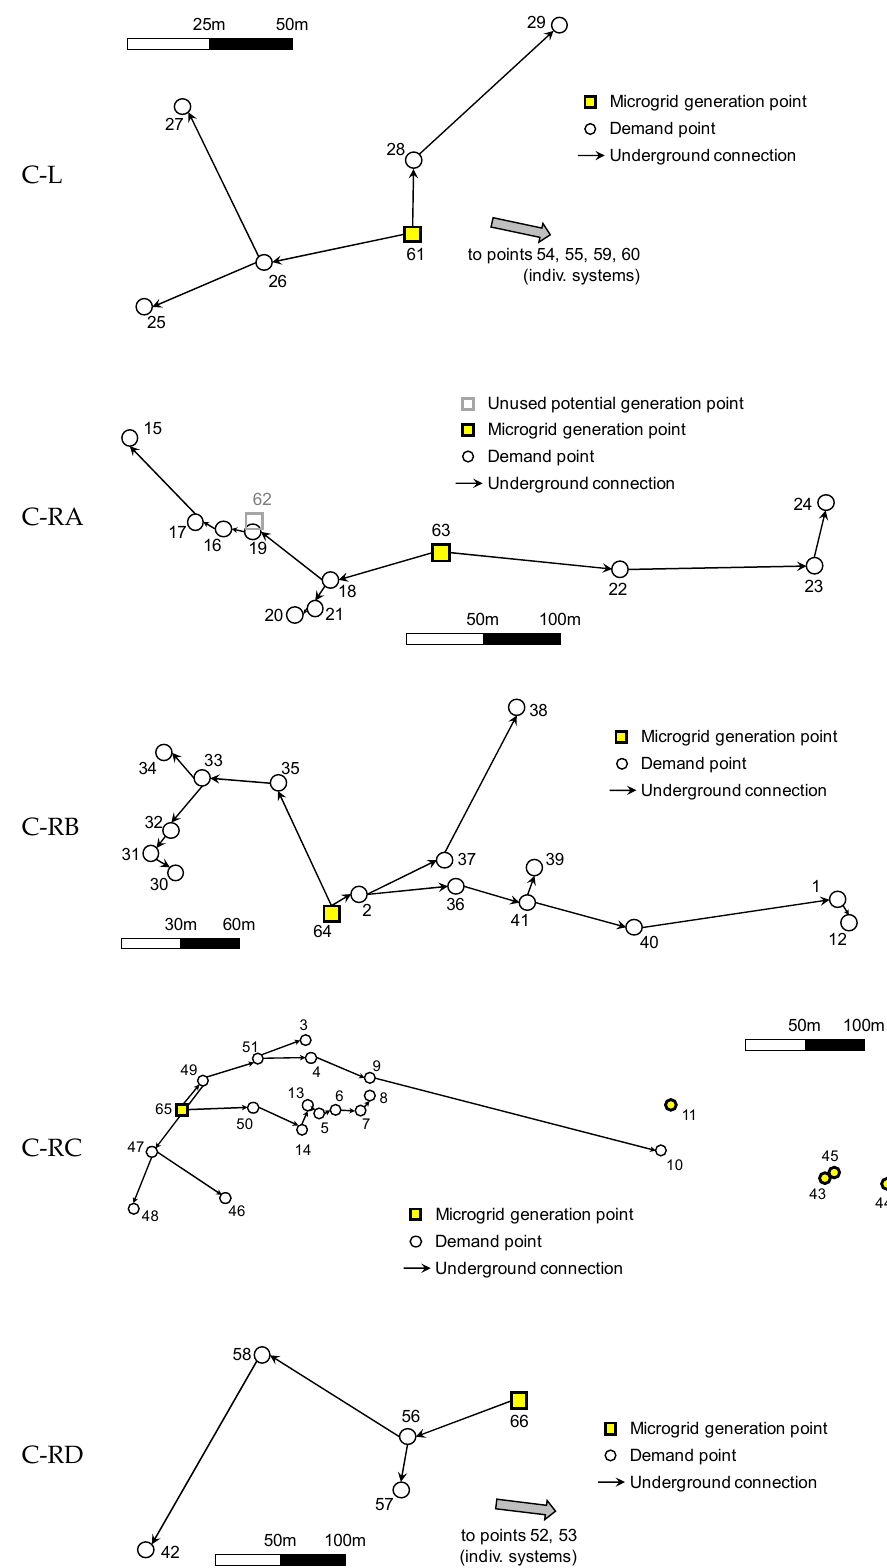
Figure 9. Microgrid/individual supply obtained for Conambo.